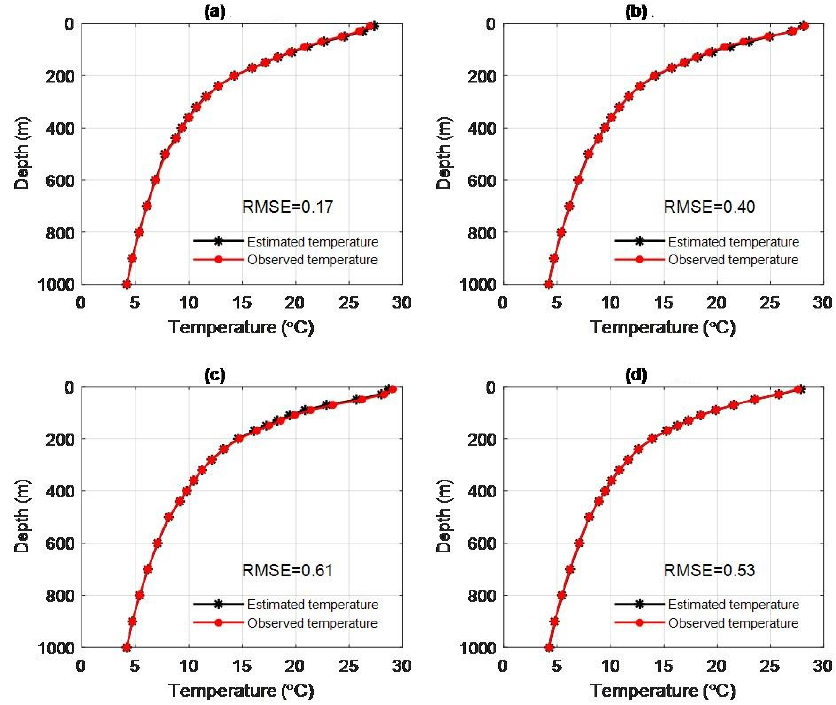
Figure 8. Comparison of area-averaged temperature profiles (( a – d ) Boxes A–D) at different depths by the Ens-ML model estimation (black star line) and Argo observation (red dotted line).